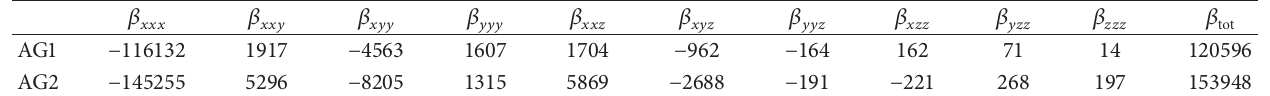
Table 4: Hyperpolarizability of AG1 and AG2.